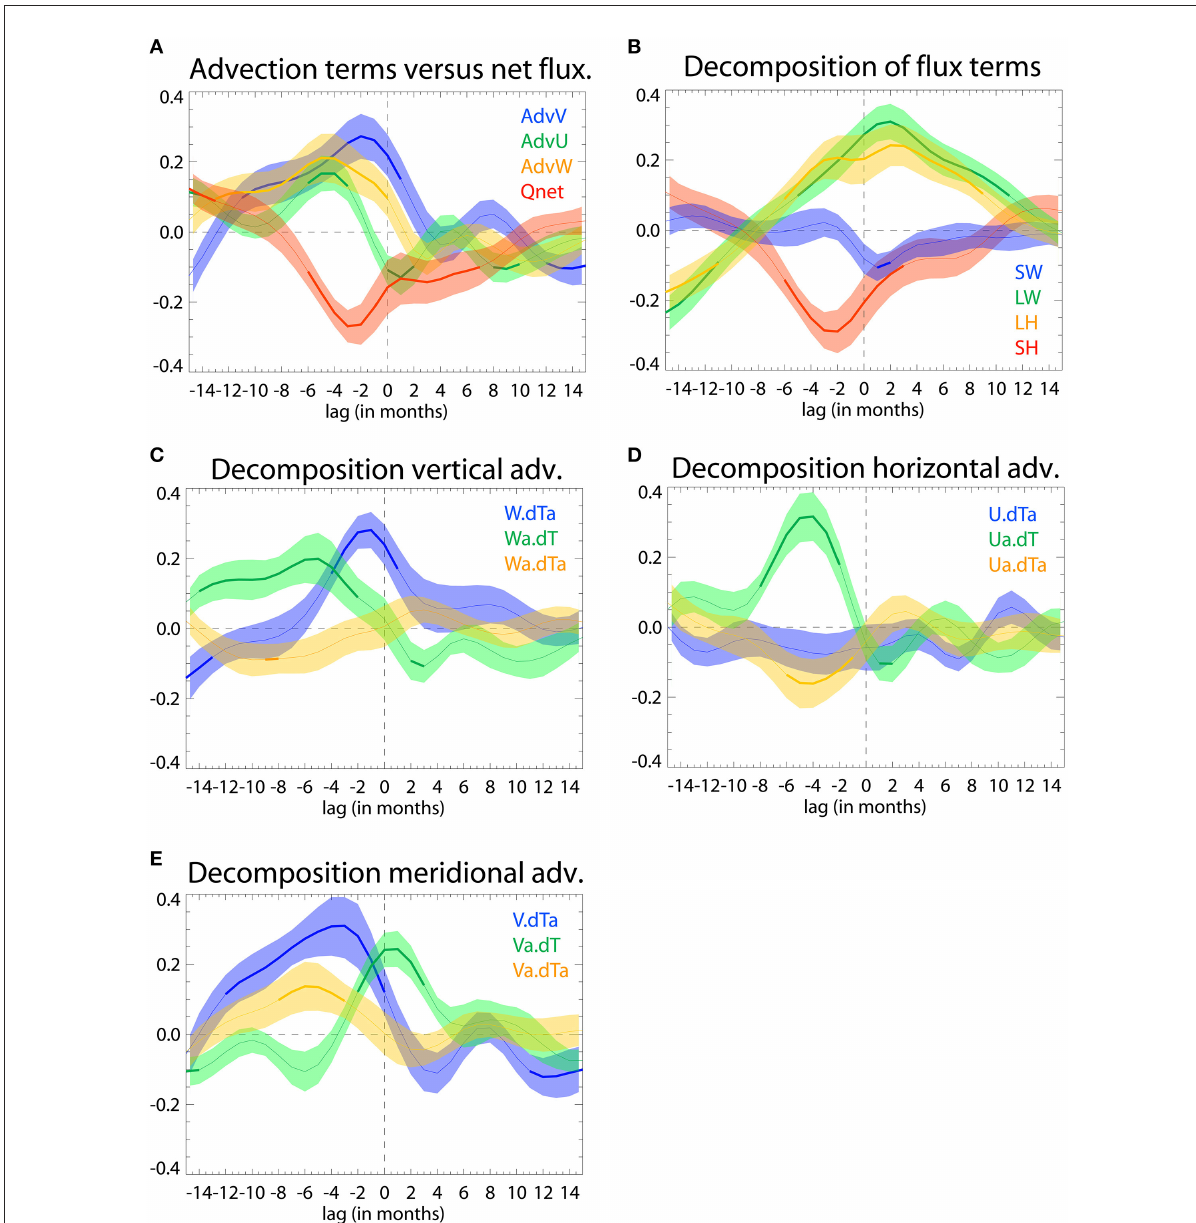
FIGURE9 Mixed-layer heat budget along the coast (15–25 ◦ S): Lagged-regression coefficient (in ◦ C/month) between the rate of change of the SPMM index (normalized by its variance) and the tendency terms. (A) Total advection and total net heat flux, (B) decomposition of the net heat flux into solar radiation (SW), longwave radiation (LW), latent heat (LH) and sensible heat (SH). Note that the shortwave radiation transmitted at 50m is removed from SW. (C) Reynolds decomposition of vertical advection, i.e., climatological vertical advection of anomalous temperature (W.dTa), anomalous vertical advection of climatological temperature (Wa.dT) and non-linear vertical advection (Wa.dTa); (D, E) same as (C) but for horizontal and meridional advection. Negative lag indicates that the tendency term leads ∂ SPMM . The shaded colored zone around the curve ∂ t indicate the dispersion amongst the members ( the standard deviation), whereas the portion of the curve in thick line indicate where the ± regression coefficient is significant at the 95% level based on a student t- test for 75% (31) of the members.